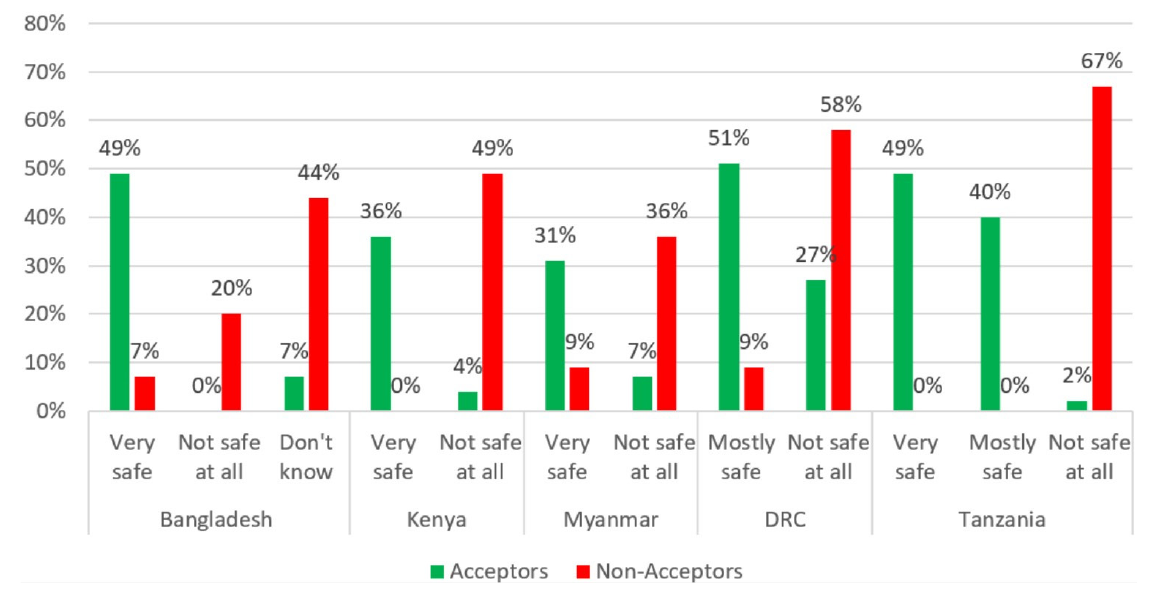
9 of 21 Figure 3. Acceptors vs. Non-acceptors: Perceived action efficacy of COVID-19 vaccines by country.